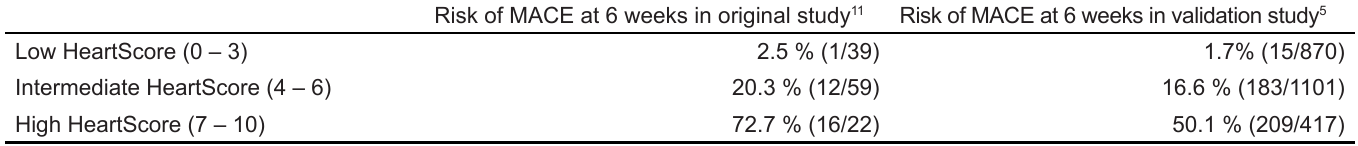
Table 5. HeartScore, risk of MACE within six weeks from ED